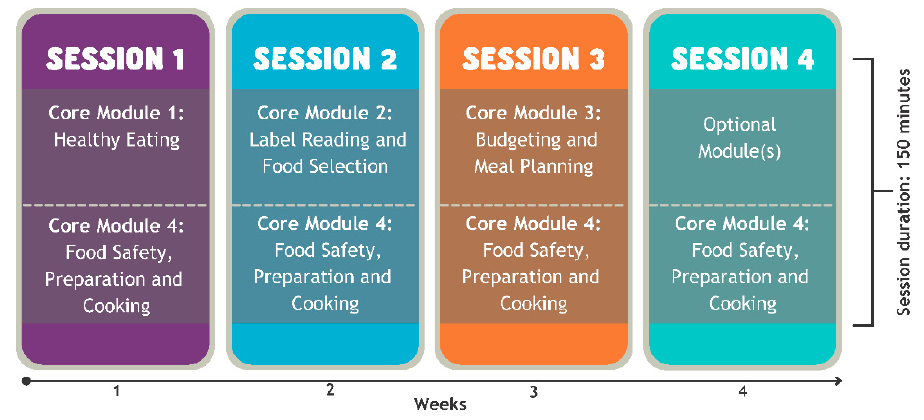
Figure 1. Food Sensations for Adults program